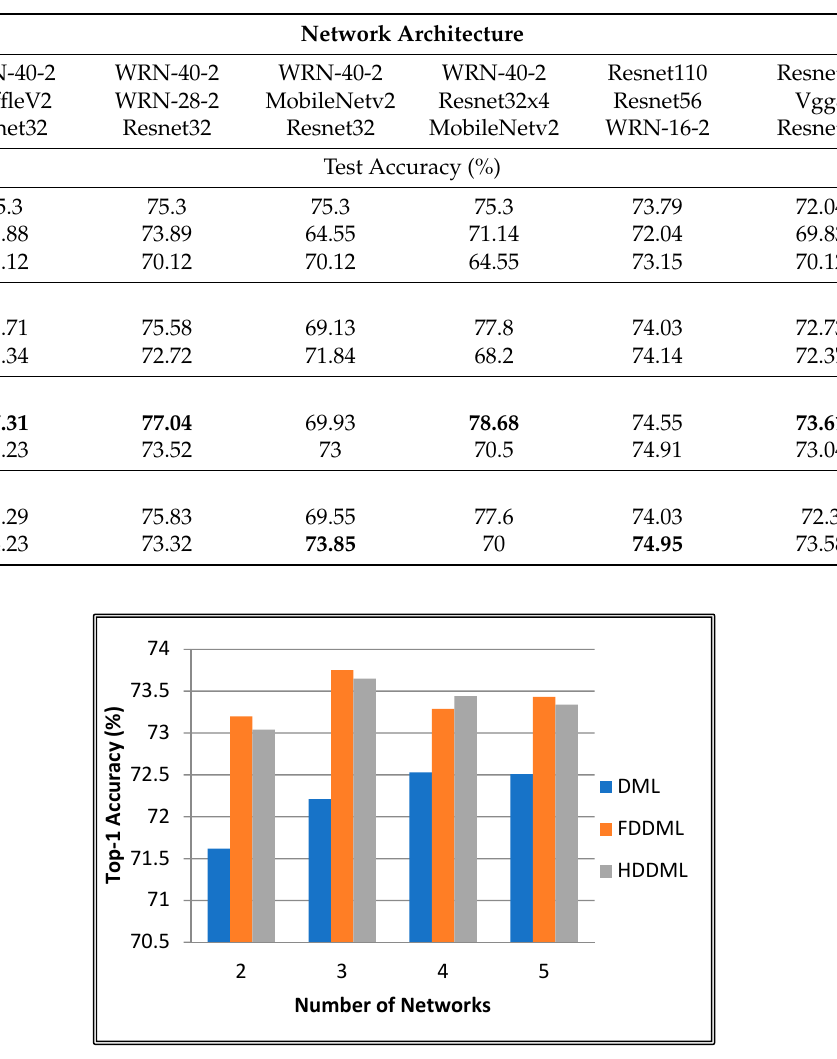
Figure 5. Accuracy performance (top-1) on CIFAR100 with teacher WRN-40-2 to different numbers of Resnet32 student networks in a cohort.